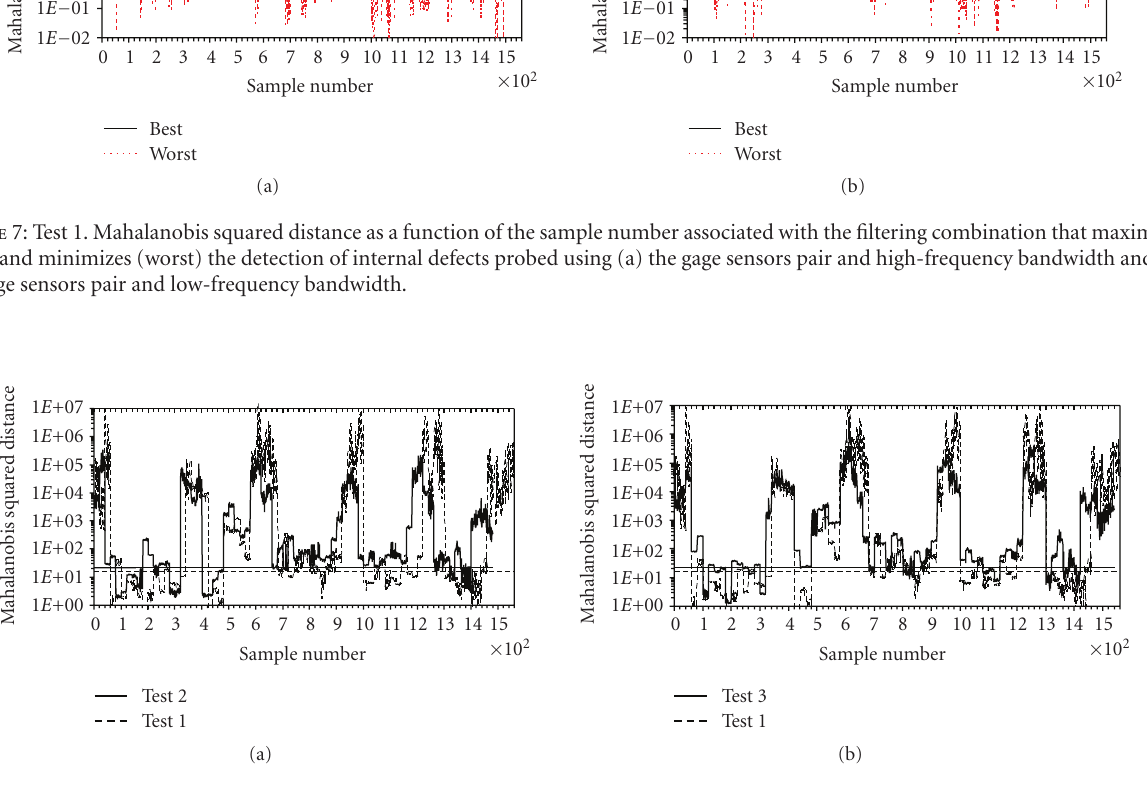
Figure 8: Mahalanobis squared distance as a function of the sample number associated with the filtering combination that maximizes (best) the detection of transverse surface defects probed using (a) the central sensors pair and high-frequency bandwidth during Test 1 and Test 2, and (b) the central sensors pair and high-frequency bandwidth during Test 1 and Test 3.